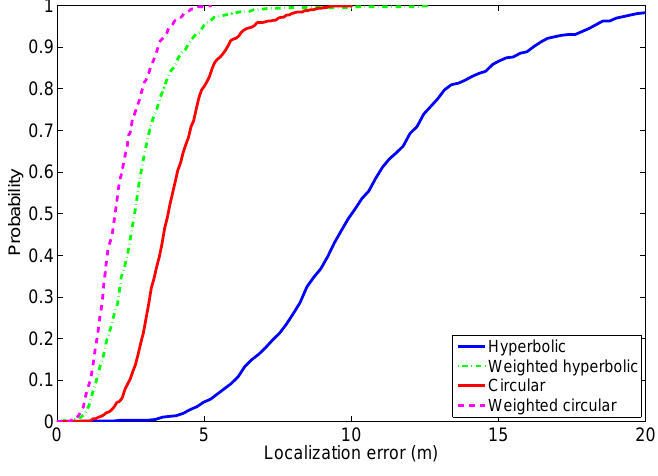
Figure 9. Cumulative distribution function of the localization error in the wireless sensor network experiment using the four positioning